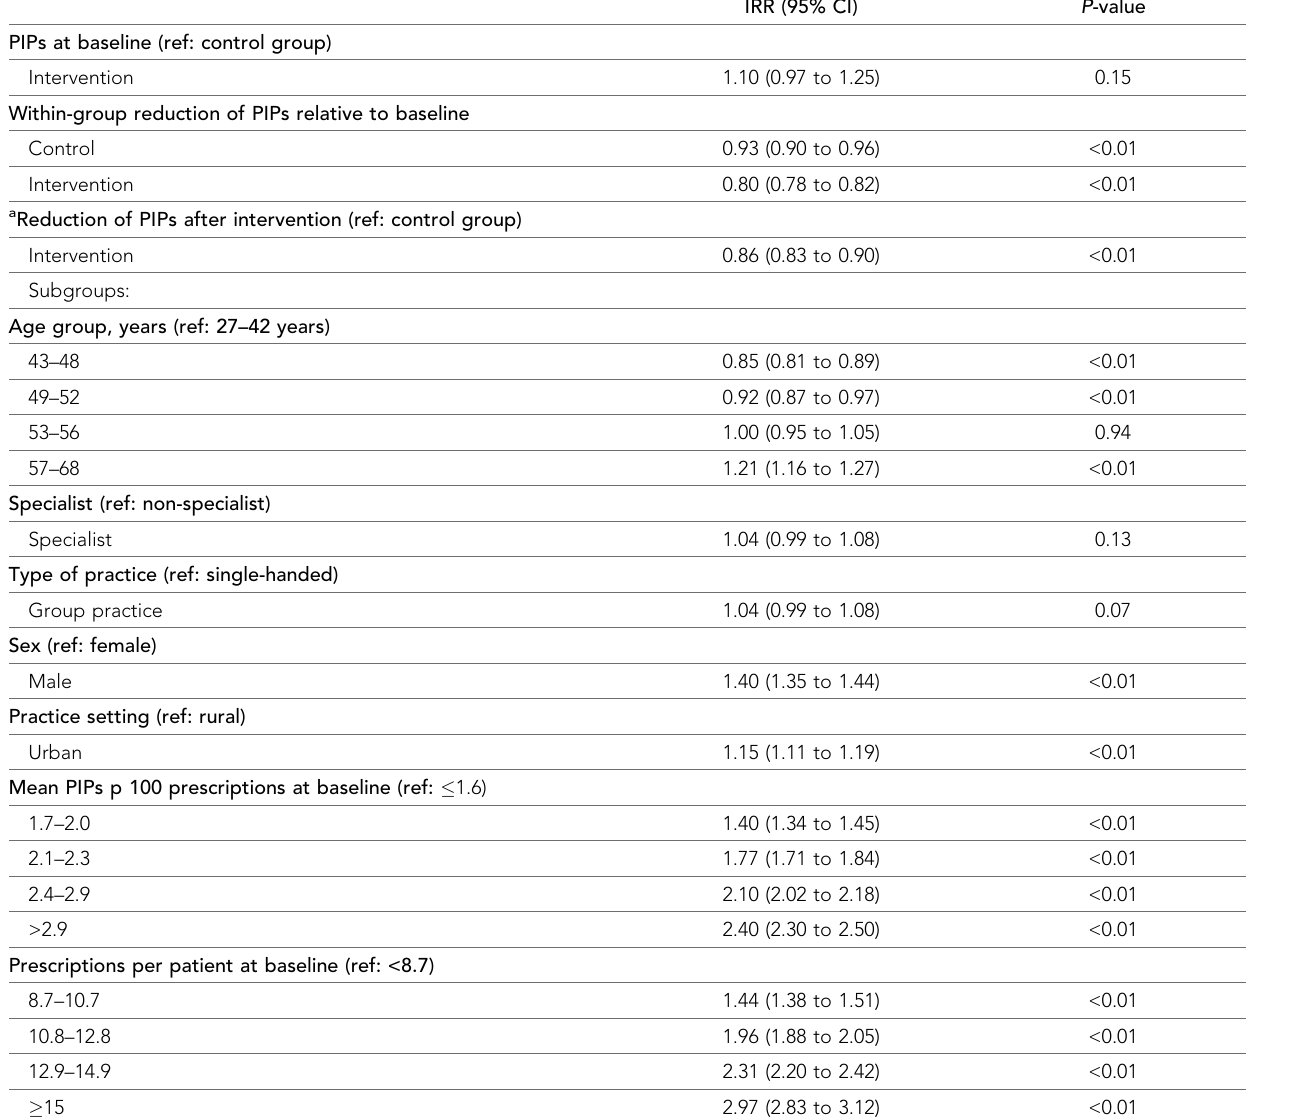
Table 2. The rate of change in PIPs in the intervention group versus the control group after adjusting for the GP subgroup characteristics. Estimates of IRRs showing the changes in PIPs per 100 prescriptions at post-intervention relative to 1 year pre-intervention obtained from the Poisson cluster effects regression